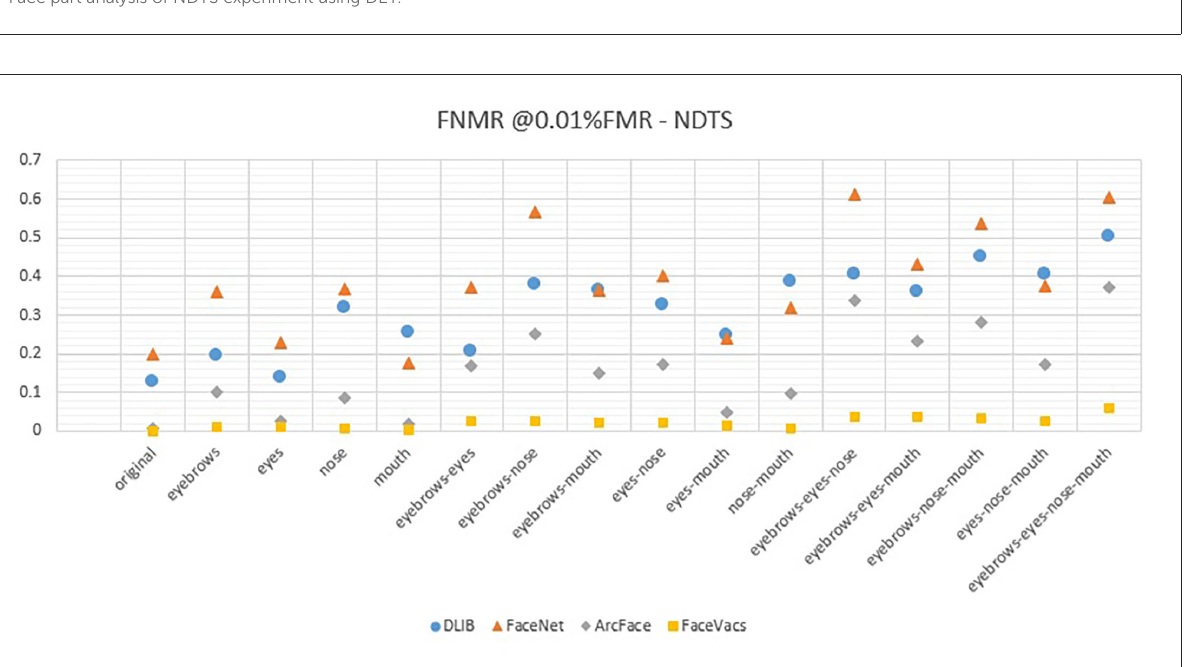
FIGURE10 The behavior of NDTS on four deep face recognition